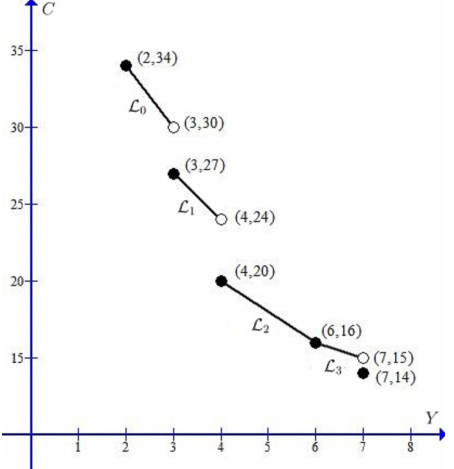
Figure 1. Trade-off